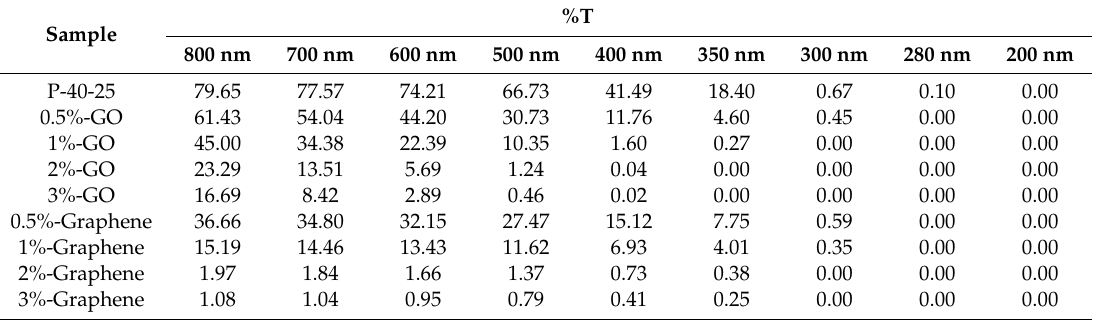
Table 4. Transmittance of the P-40-25 film modified with varying levels of GO and graphene content.